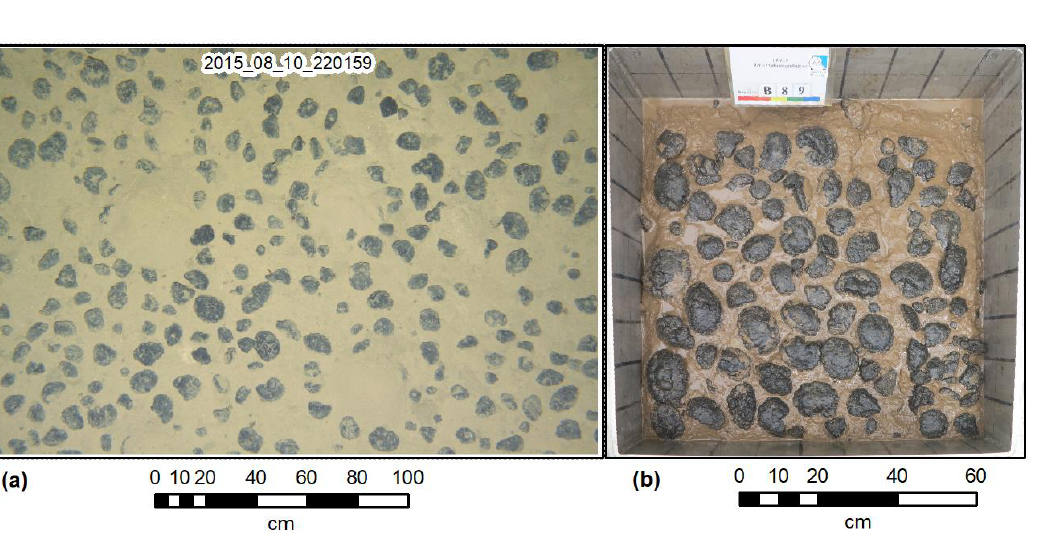
Figure 1. Example towed seabed photo ( a ) and box-core sample ( b ). Mounds of clay-ooze without nodules in the seabed photo are caused by bioturbation.